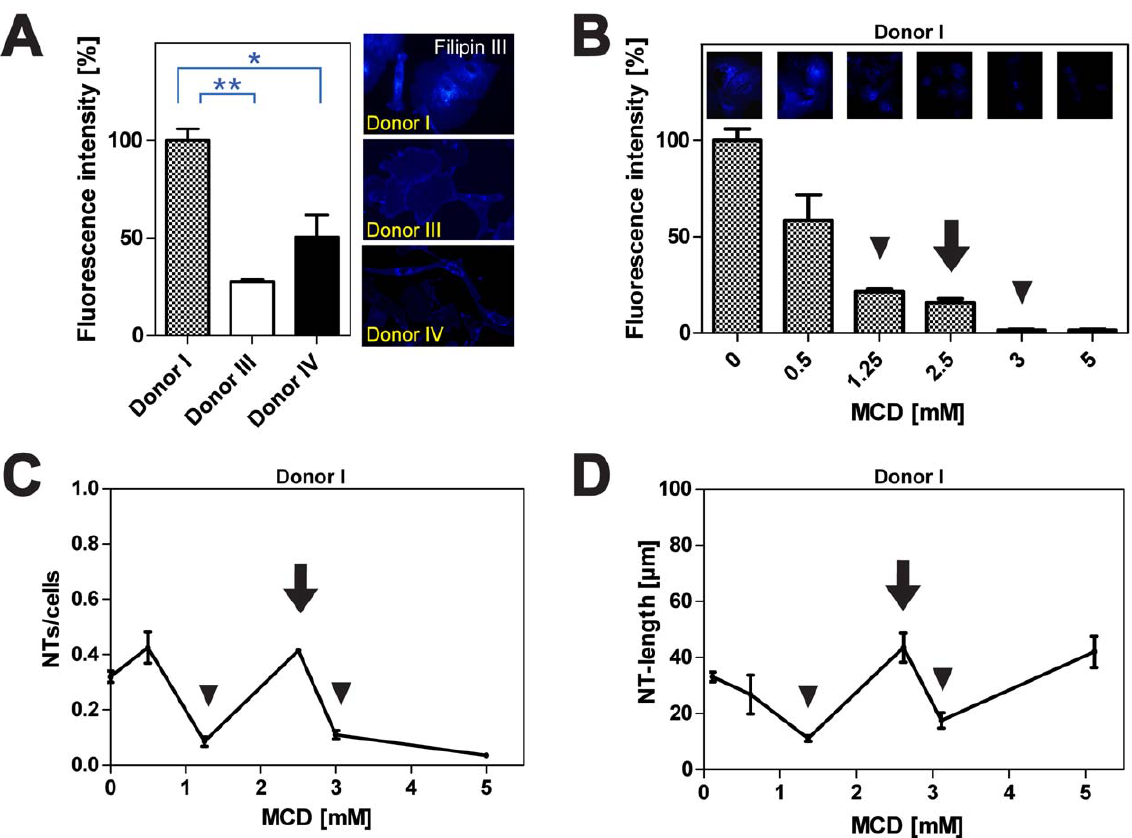
Figure 3. Impact of MCD mediated cholesterol depletion on NT formation. ( A ) Quantitative analyses of fluorescence intensities after cholesterol staining with Filipin III in HPMCs from different donors (left panel). Corresponding fluorescence images of stained cells one hour after cell plating are shown (right panel). ( B ) HPMCs were cultured in absence or presence of indicated MCD concentrations and Filipin III staining was performed one hour after plating. For quantification, fluorescence intensities based on representative microscopic images (top row) were determined as described. Please note that cholesterol depletion results in a decrease of fluorescence intensities (arrowheads, arrow). ( C ) Analysis of the NTs/cells ratio dependent on cholesterol depletion. HPMCs were treated with indicated MCD concentrations and NT numbers were assessed one hour after cell plating. The graph shows a significantly higher number of NTs when cells are treated with 2.5 mM MCD (arrow) as compared to the control or treatment with 1.25 or 3 mM MCD (arrowheads). ( D ) Quantitative analyses of NT lengths after cholesterol depletion. HPMCs were cultured in the presence of indicated MCD concentrations and NT lengths were analyzed one hour after cell seeding. Incubation of cells with 1.25 mM MCD led to comparatively short NT lengths (arrowhead) whereas incubation with 2.5 mM MCD led to extended NT lengths (arrow). All data are means 6 SEM. * p , 0.05, ** p , 0.01 ( t -test in A ).